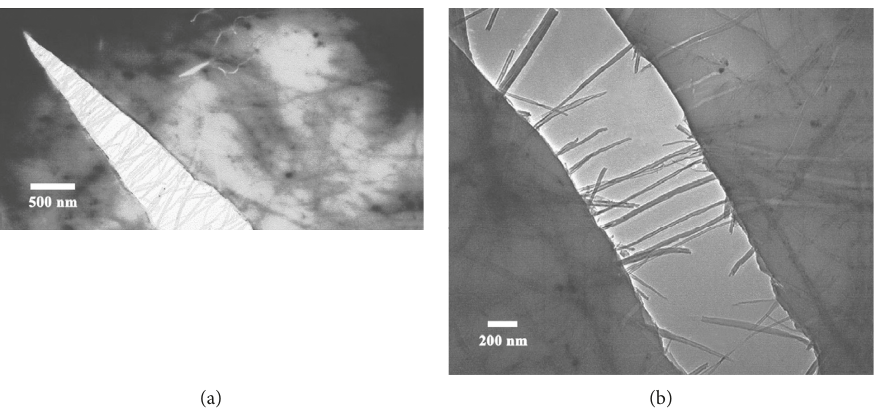
Figure 12: In situ transmission electron microscopy images of crack nucleation and propagation induced by thermal stresses in a polystyrene thin film reinforced with multiwalled carbon nanotubes. (a) Such a crack propagates along relatively low density regions of carbon nanotubes or along weak interfaces. (b) The multiwalled carbon nanotubes tend to align and bridge the crack wake, and subsequently to break and/or pull out from the polymer matrix (adapted with permission from reference [212]; copyright 2000, American Institute of